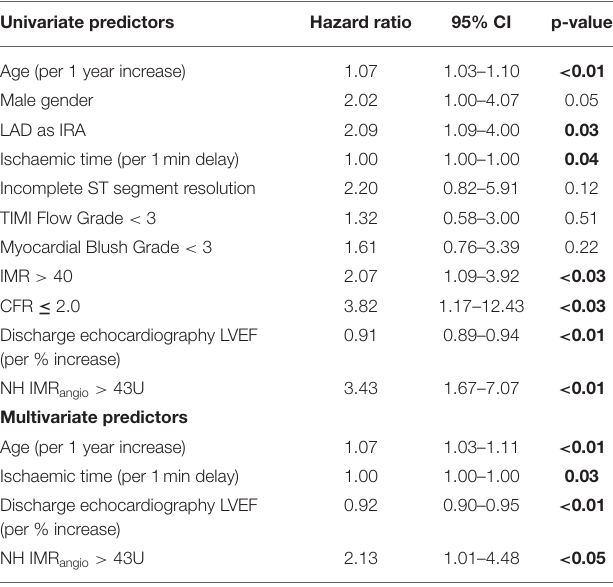
TABLE 3 | Univariate and multivariate analysis results for predictors of all-cause mortality, resuscitated cardiac arrest, new heart failure. Univariate predictors